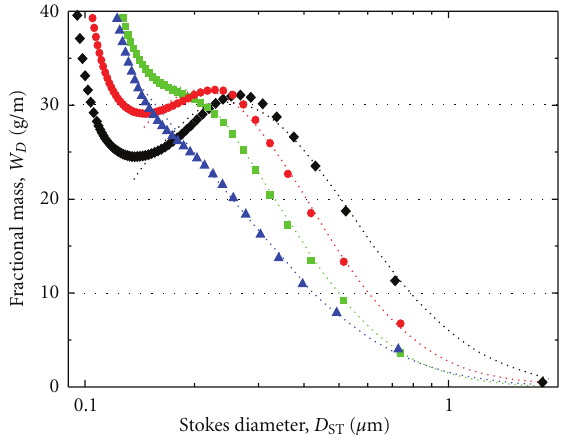
Figure 15: Particle size distributions of CNTs (symbols) at di ff erent sonication times at 40% tip amplitude: 10min ( (cid:3) ), 1 h ( • ), 2h ( (cid:2) ), and 3h ( (cid:4) ). The dotted lines show the corresponding fitted log- normal